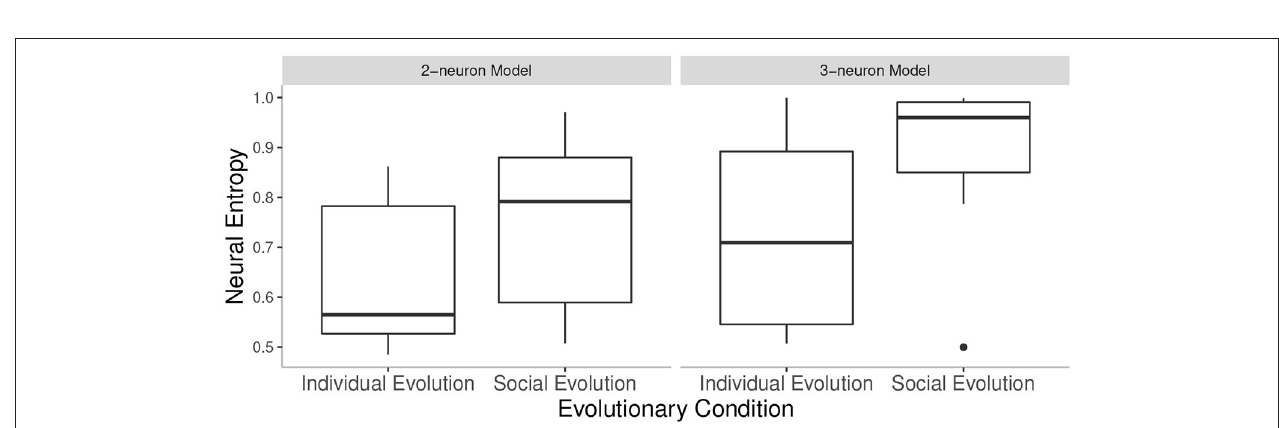
FIGURE 3 | Neural entropy values in all conditions tested: values from the best agent (IE) or agent pair (SE) in the last generation in 10 runs of each condition. Note that the outlier in SE of 3-neuron model was not removed from the analysis.